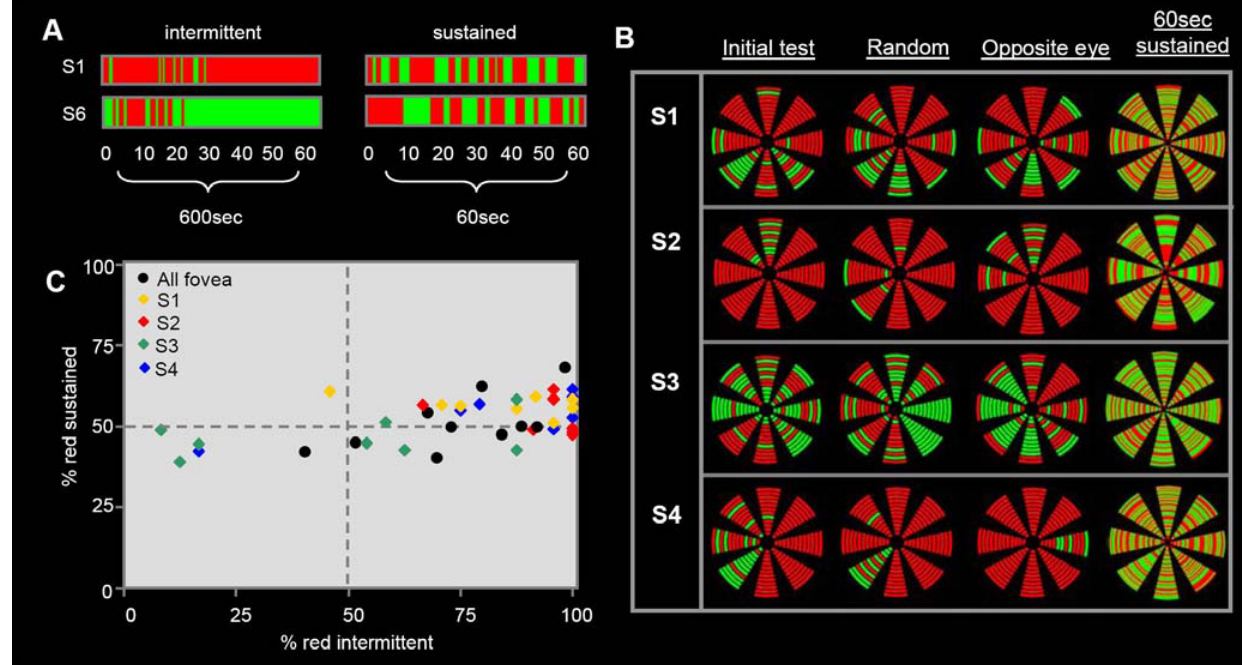
Figure 2. Results from experiment 1 and 2. (A) The pattern of perceptual dominance for two representative subjects during foveal presentation of rivalry targets. The left column depicts results for 60 intermittent 1sec presentations (9 sec inter-stimulus intervals). During this condition there was no evidence of perceptual stabilization. Subjects reported large perceptual biases that were broken by brief intermittent dominance of the alternative targets. In contrast, no biases in perceptual dominance were observed during 60sec of sustained target presentation. (B) Data from all 4 subjects tested with the peripheral presentation in experiment 2a–d. The left column shows results from the initial test of sequential (clockwise or counterclockwise) presentation. During the 2min trial duration the targets cycled through the same 8 locations 12 times (each wedge represents a single location in space, with time represented in radial distance from the center ring). In this condition, perceptual dominance shows strong localized biases. Similar biases were also observed when the order of presentation was randomized (columns 2 nd and 3 rd from the left respectively), however, the relative locations of the biases were not necessarily conserved. No systematic biases were observed during 60sec of sustained presentation at each of the 8 locations (4 th column). (C) A plot of the proportion of red dominance reported during intermittent (x-axis) and sustained target presentation (y-axis) for the foveal (black circles) and 8 peripheral target locations (color diamonds correspond to the 4 subjects tested in experiment 2). Despite very little bias in dominance during sustained viewing subjects reported large biases during intermittent viewing across all target locations.